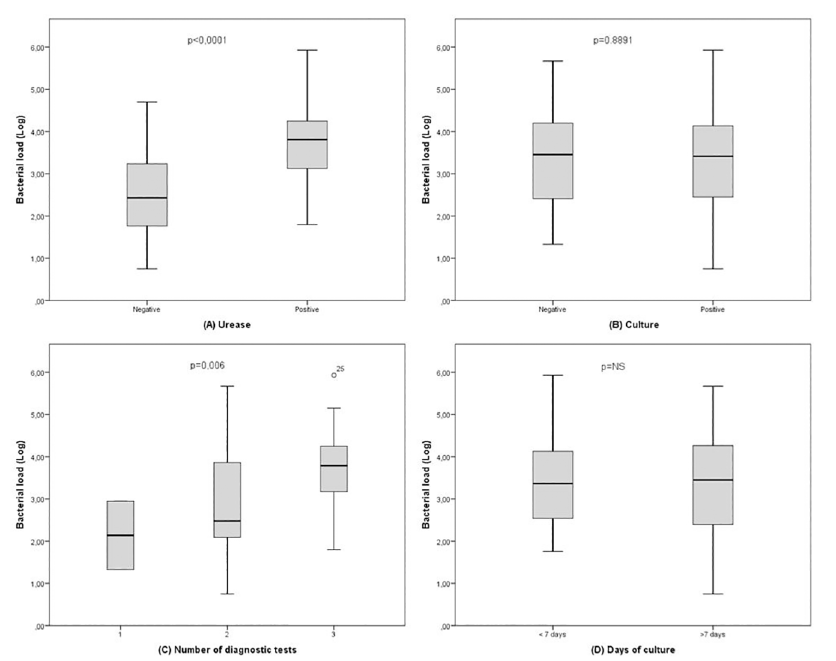
Fig 4. Comparison of average H . pylori DNA between different diagnostic